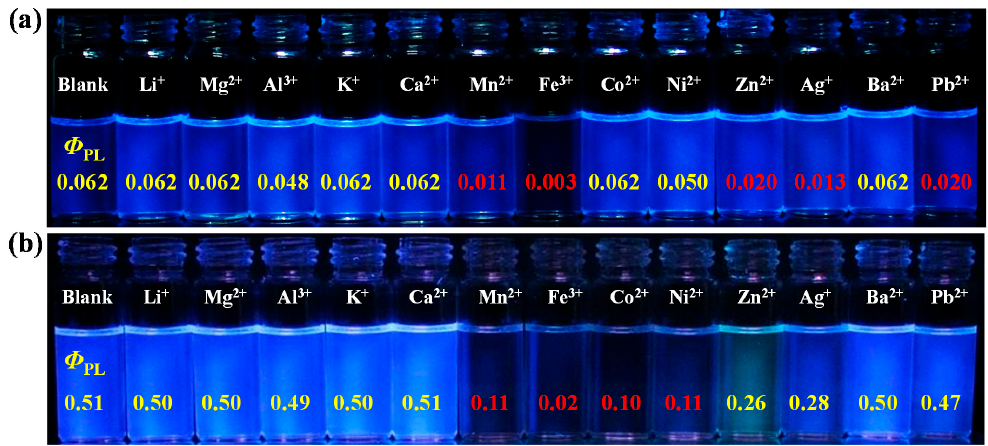
Figure 4. Fluorescence colors of ( a ) PCaT and ( b ) PCT solutions after the addition of various cations. The values in images are their corresponding quantum yields ( Φ PL s) after adding the given